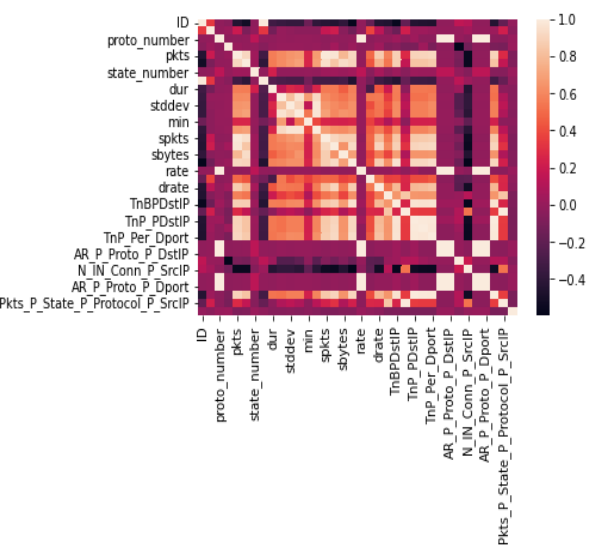
Figure 3. Correlation Matrices IoT based